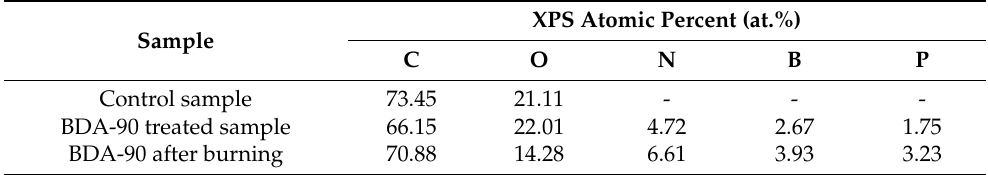
Figure 5. Photographs of vertical burning test of the control sample: ( a ) BDA ‐ 30; ( b ) BDA ‐ 60; ( c ) BDA ‐ 90; ( d ) BDA ‐ 120; ( e ) treated samples (3 curing time, 50 LCs).